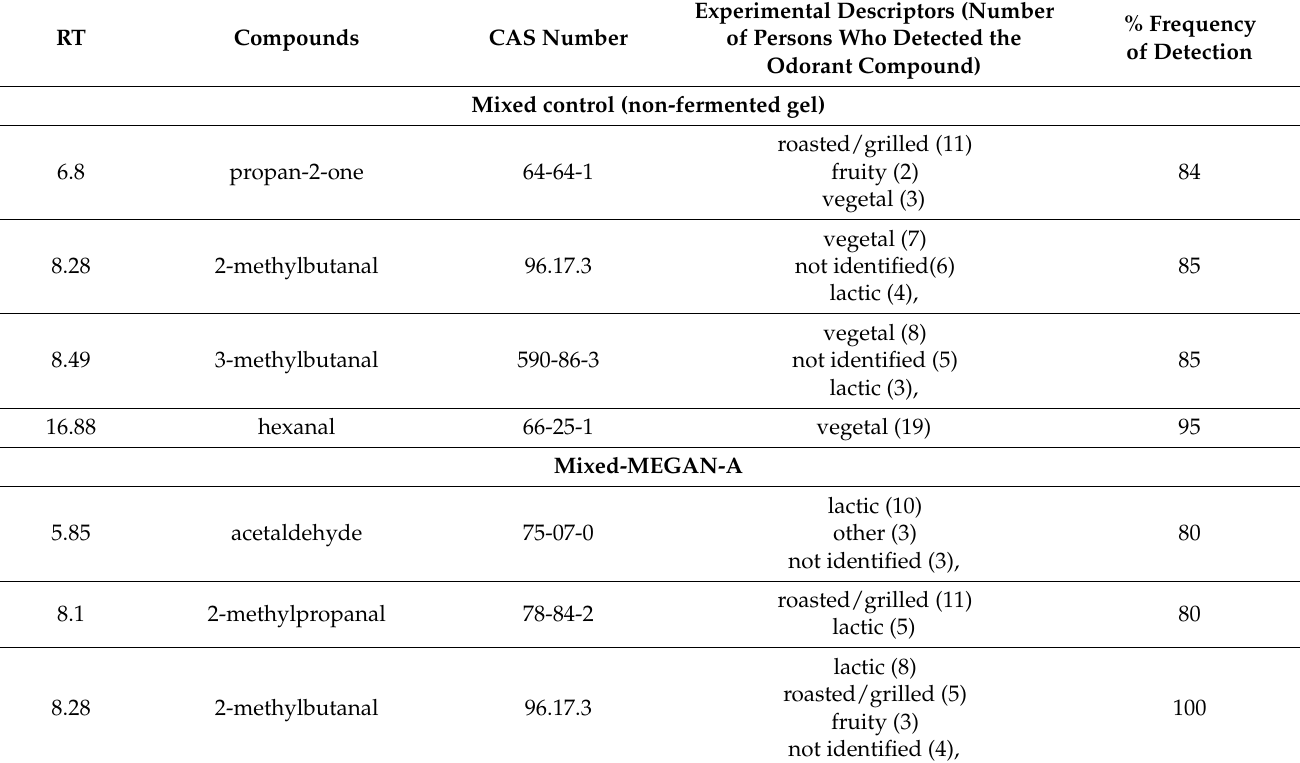
Table 2. Odorant compounds identified in the mixed gels: control sample (not fermented gel) and mixed MEGAN-A gels (after three days of